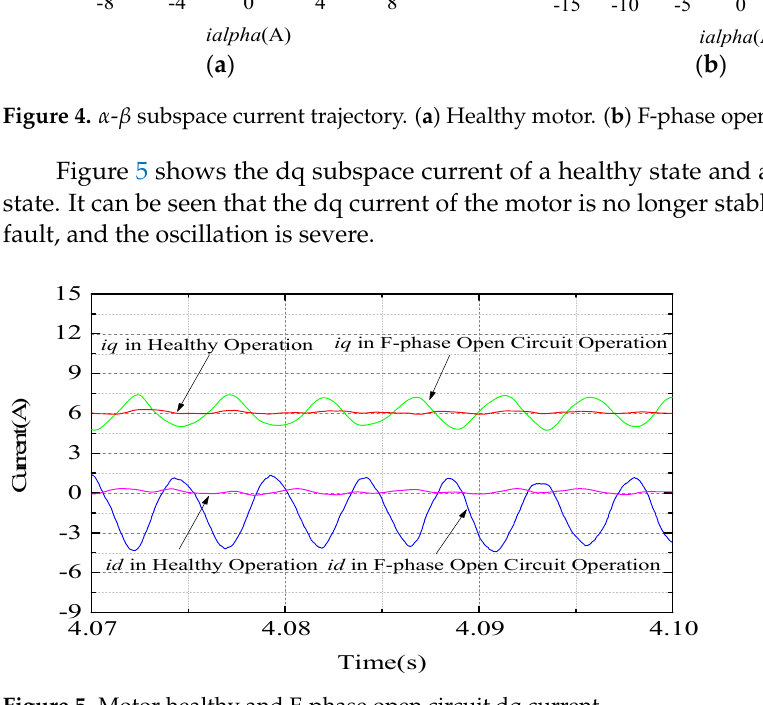
Figure 5. Motor healthy and F-phase open circuit dq current.